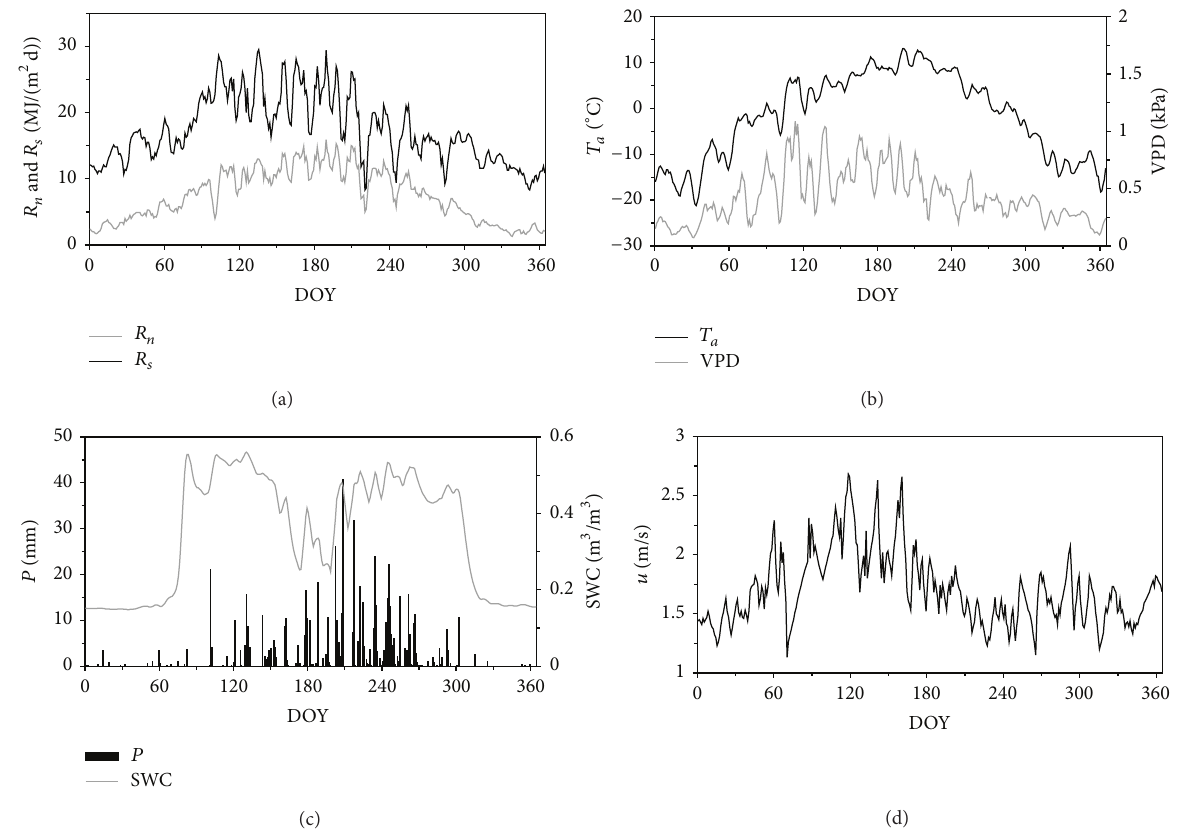
Figure 2: Temporal variations of (a) net radiation ( 𝑅 𝑛 ) and solar radiation ( 𝑅 𝑠 ), (b) daily mean air temperature ( 𝑇 𝑎 ) and vapor pressure deficit (VPD), (c) daily precipitation ( 𝑃 ) and soil water content at 5 cm depth (SWC), and (d) wind speed ( 𝑢 ) in the swamp meadow during 2004.